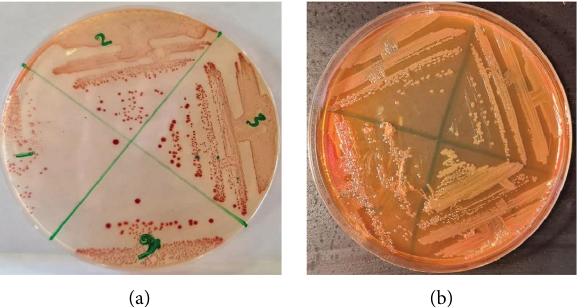
Figure 1: (a) Red colonies of A. baumannii on CHROMagar ™ Acinetobacter agar. (b) Nonlactose fermenter colonies of A. baumannii on MacConkey agar.